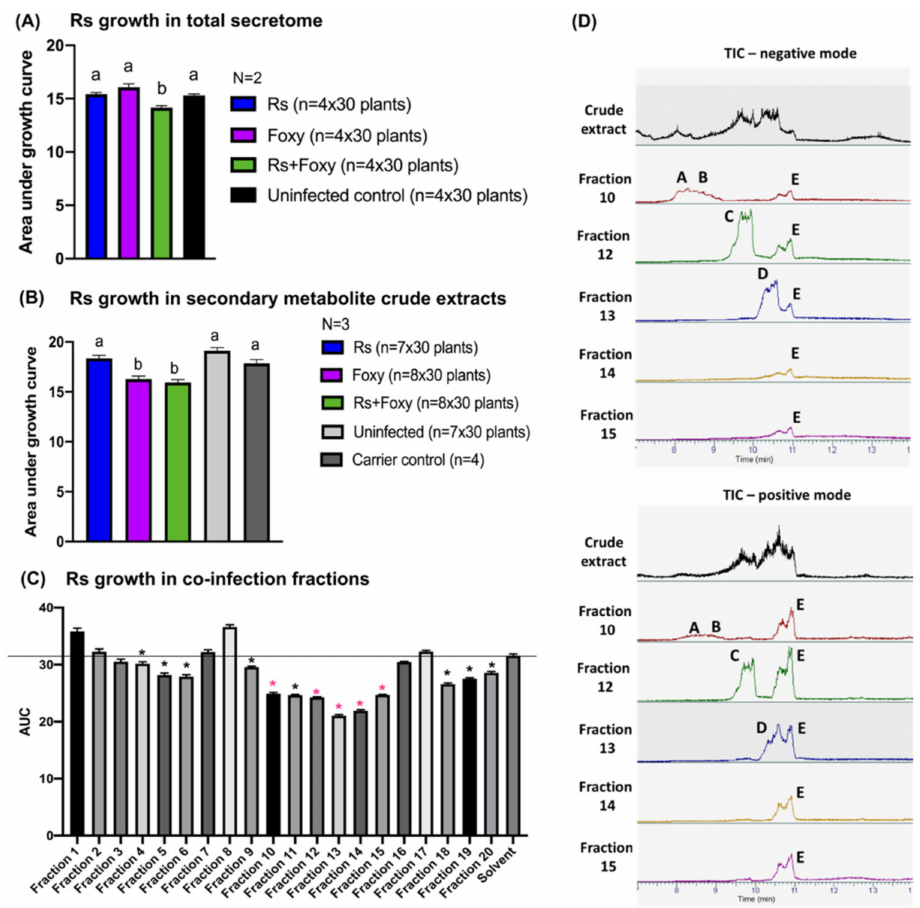
Figure 4. Crude extracts from the co-infection secretome reduce in vitro R. solanacearum growth. ( A ) shows area under growth curve (AUC) for 42 h post inoculation (hpi). R. solanacearum was inoculated in total secretome (including plant and microbial secretions) from different treatments as indicated. Bacterial growth in co-infection secretome was significantly reduced compared to secretomes from single infections (ANOVA p = 0.0003; Rs vs. Rs+Foxy—Tukey’s p = 0.0049; Foxy vs. Rs+Foxy—Tukey’s p = 0.0001). ( B ) shows R. solanacearum growth as AUC up to 48 hpi in crude extracts eluted into ethyl acetate. ANOVA p < 0.0001. Rs vs. Rs+Foxy—Tukey’s p = 0.0005; Foxy vs. Rs+Foxy—Tukey’s p = 0.9260. ( C ) Co-infection crude extract was fractionated and R. solanacearum growth was quantified in each fraction. ANOVA p < 0.0001. Bonferroni correction was performed to compared AUCs between each fraction with the solvent control * p < 0.05. The fractions marked in pink * ( p < 0.0001) were chosen for further analyses in ( D ) and Figure 4. ( D ) Total ion chromatograms (TIC) of the fractions in positive and negative modes run on HR-ESI-MS. The m/z of these peaks ( A – E ) are reported in Table